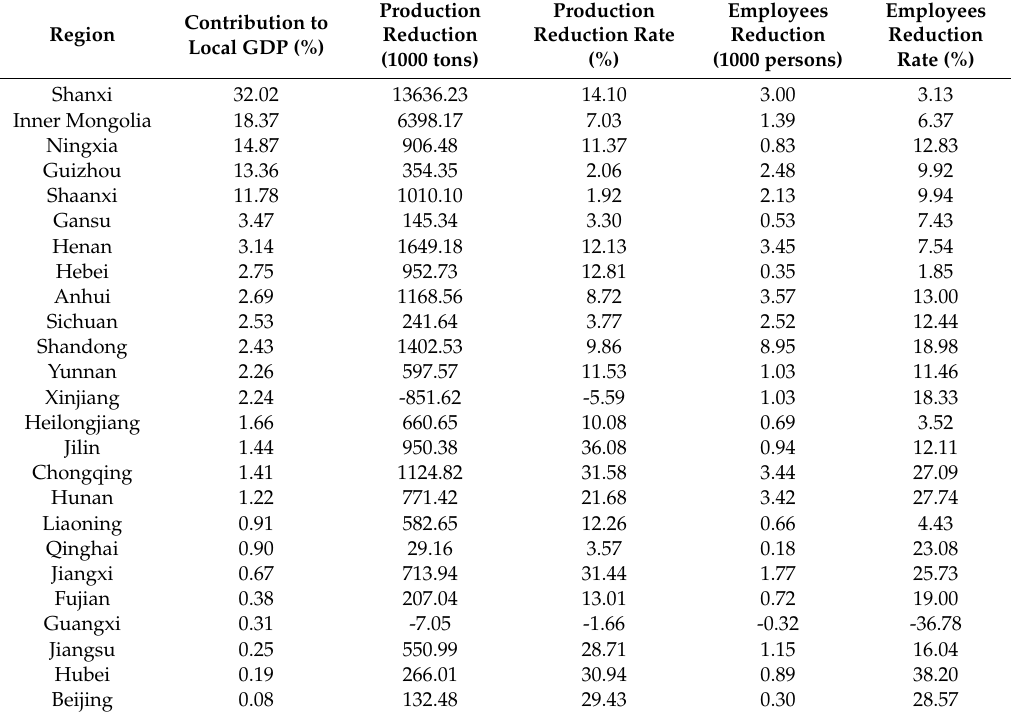
Table 5. Contribution of the coal industry to local gross domestic product (GDP) and policy e ff ect di ff erences in